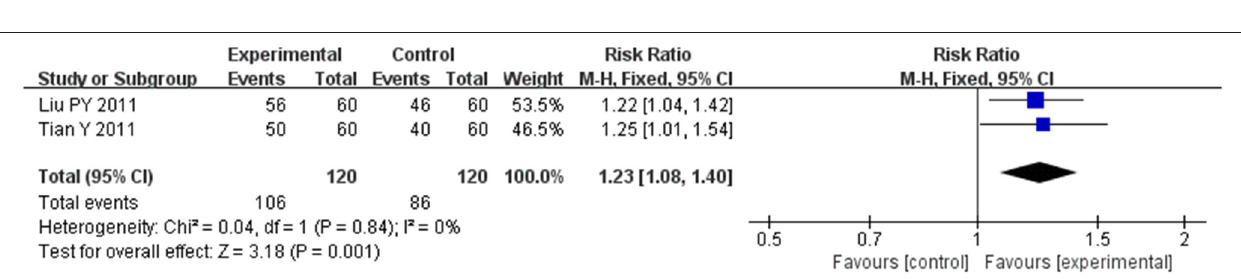
FIGURE 12 | Forest plot of the comparison between CHM and control for clinical efficacy rate as measured using Lee’s Criteria for Determining Heart-Failure